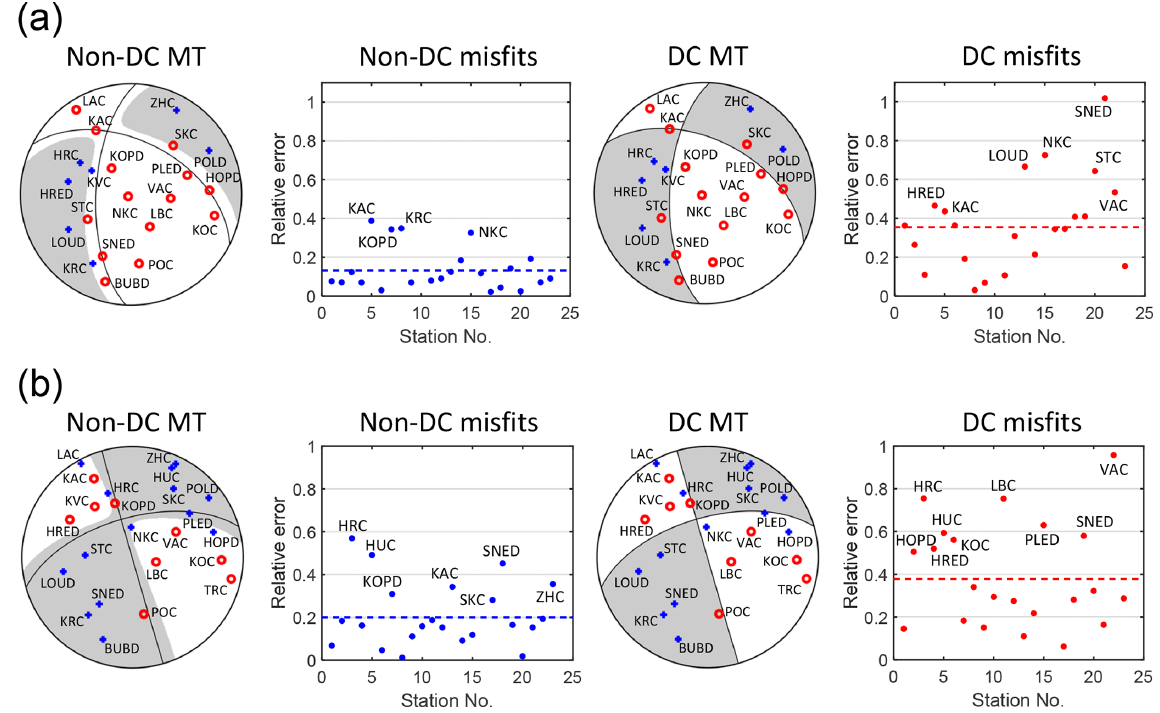
Figure 7. Inversion for the full MT solution (“Non-DC MT” and “Non-DC misfits”) and for the DC solution (“DC MT” and “DC misfits”) for earthquakes in Fig. 6. The mean amplitude misfits for the full MT and DC solutions are shown by dashed blue and red lines, respectively.